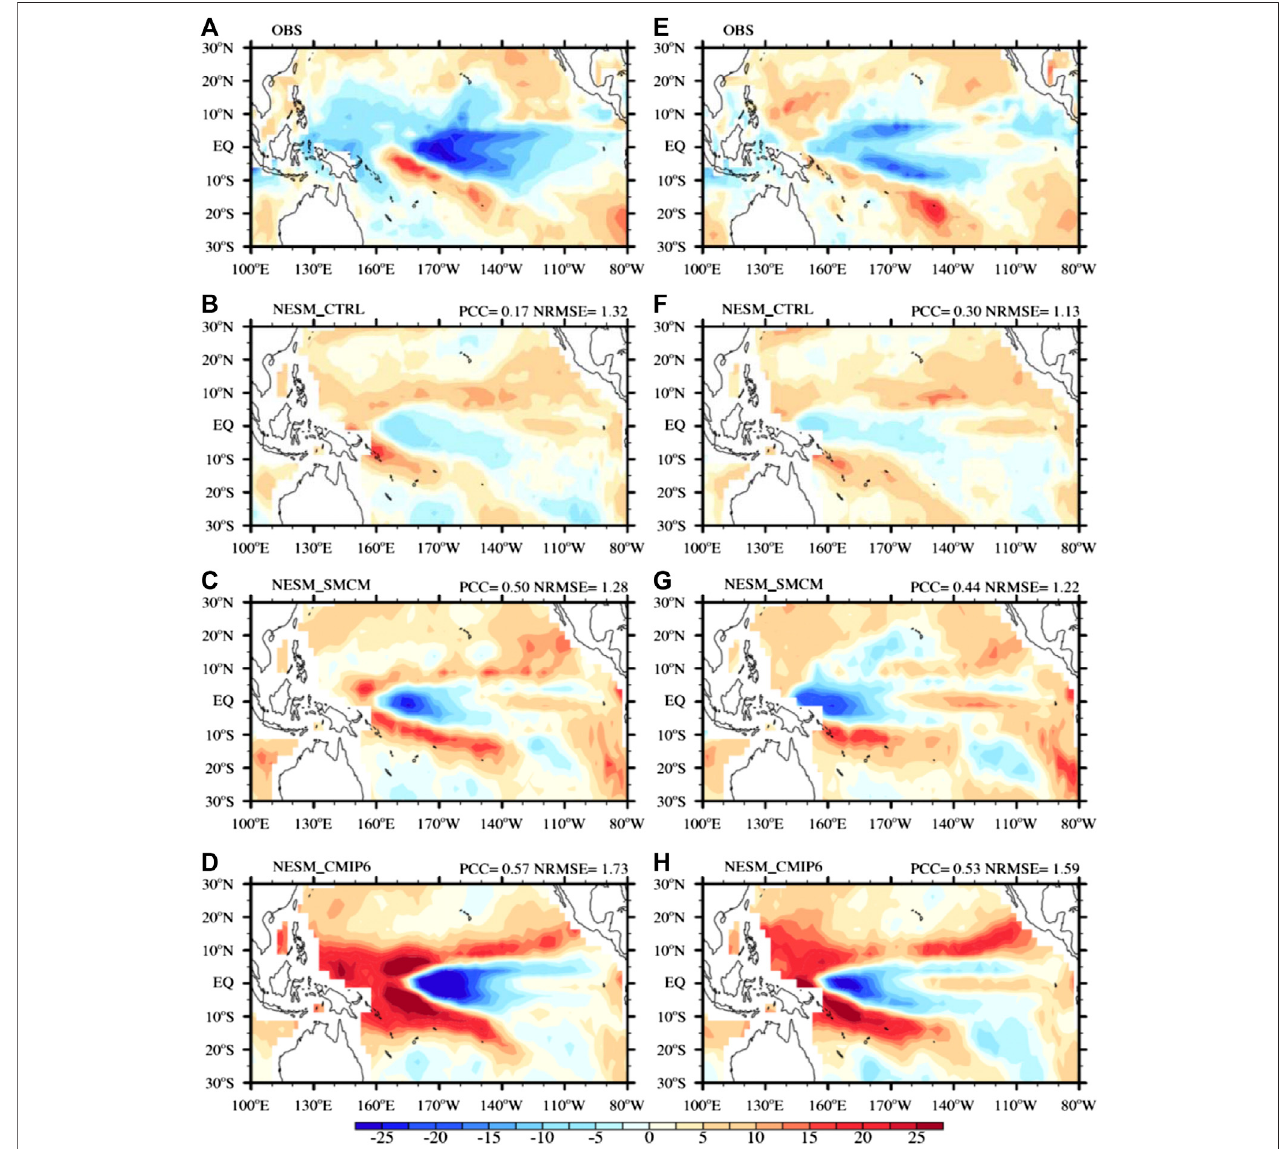
FIGURE 10 | The response of the shortwave CRF to the SSTA changes (W m − 2 / ° C) during the period of the positive (left panel) and negative (right panel) Niño-3 SSTA for the (A,E) observations, (B,F) NESM_CTRL, (C,G) NESM_SMCM, and (D,H) NESM_CMIP6.